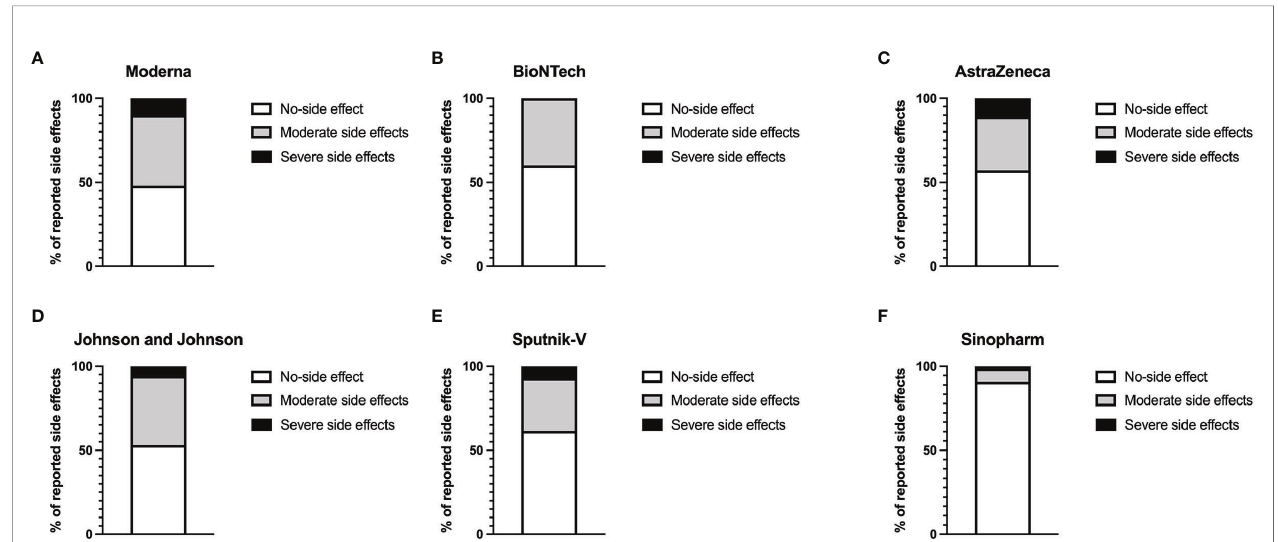
FIGURE 1 | Level of reported systemic adverse reactions. Graphs represent the proportion of individuals presenting side effects in Moderna (A) , BioNTech (B) , AstraZeneca (C) , Johnson and Johnson (D) , Sputnik-V (E) , and Sinopharm (F) vaccinees. The white parts of the histograms indicate the percentage of persons with no systemic side effects. The grey portions represent the percentage of people with mild side effects, while the dark parts indicate the percentages of individuals with severe side effects.